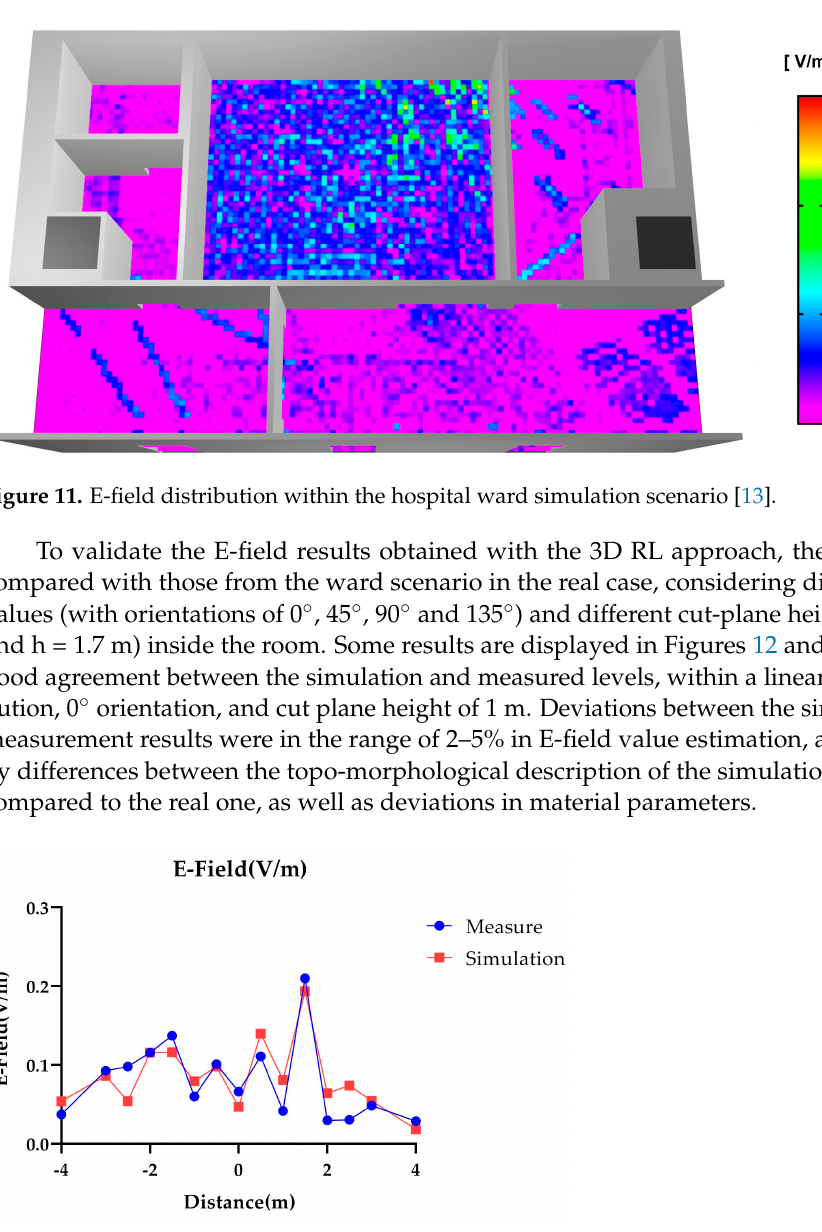
Figure 12. E-field estimation within a linear radial distribution, 0 ◦ orientation, cut plane height 1 m